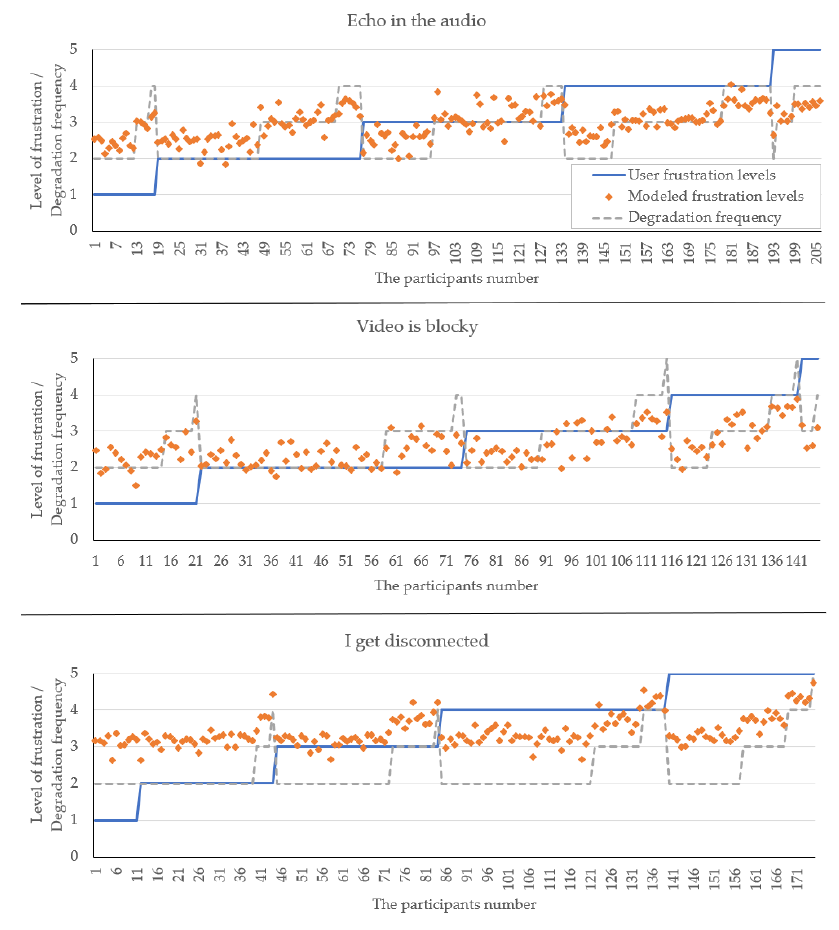
Figure 3. Participants’ frustration levels, degradation frequency, and modeled frustration levels for three quality degradation types. three quality degradation